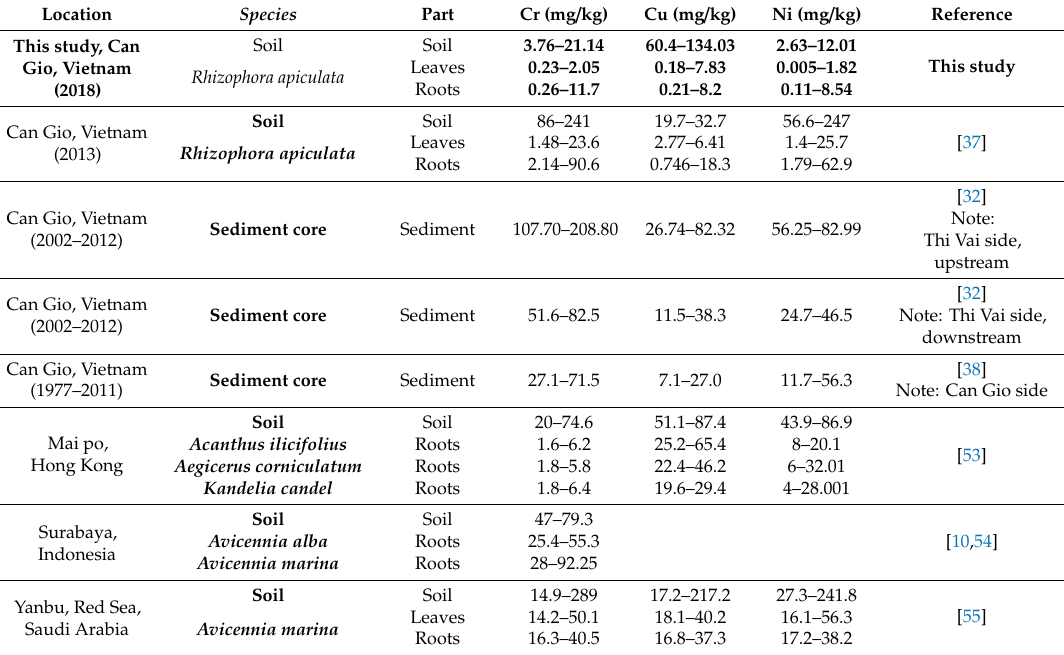
Table 3. Range of heavy metal concentrations in the soil, mangroves leaf and root of the Can Gio Mangrove Forest and of the other mangroves